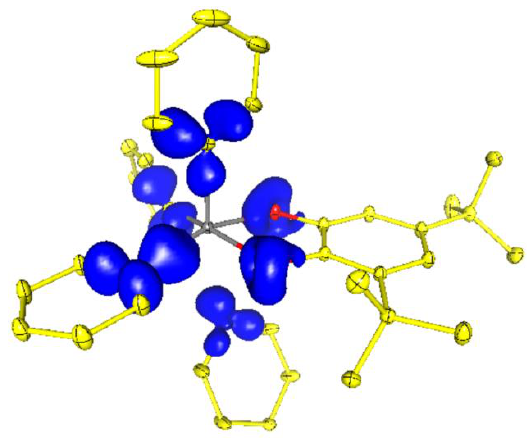
Figure 10. DED isosurface (0.1 a.u.) in the asymmetric unit of 5 ED . Table 1. Basic topological characteristics of the electron density in 5 ED .